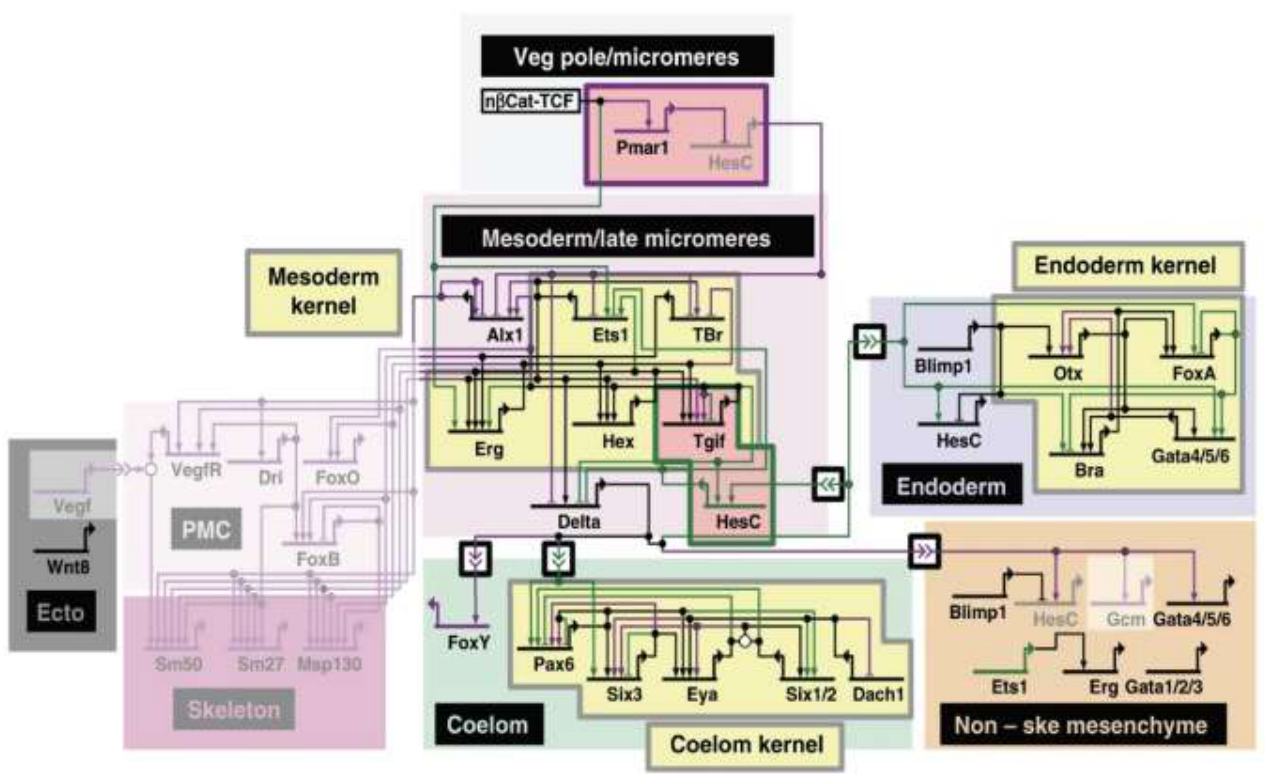
Figure 1. Gene regulatory network showing conserved kernels and both shared and species-specific subcircuits. A schematic of the GRN for endomesoderm specification for both sea urchin and sea star is depicted (see ref. [7] for details). Genes are shown in the different regions (colored boxes) where they are expressed during development. Activating inputs are represented by arrows and repressive inputs by bars. Intercellular signaling is shown using double arrowheads. Purple genes and linkages are unique to sea urchin, while green is specific to sea stars, and black are those in common. The “kernels” (yellow) and distinct subcircuits (pink) are highlighted. The greyed-out backgrounds indicate network circuits absent in sea stars. Image credit: © Cary et al. [7], used with permission under CC-BY 4.0 license.